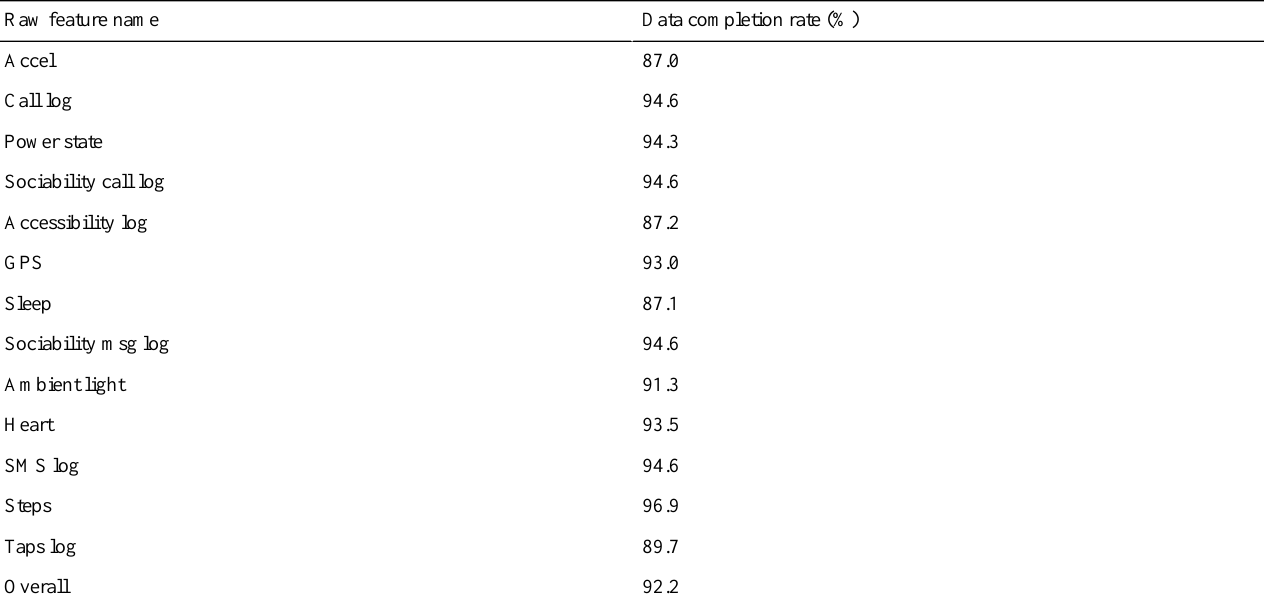
Table 1. Data completion rate on 22 participants that have completed the study.